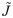
Long-range interactions can stabilize Counter patterns against variations in system size and morphogen signal.(A) Morphogen signal for three different system sizes, N = 50, 60, 70. Posterior boundary of the system is depicted as a dashed line. We consider how a two-gene Counter network, optimized for N = 60, changes upon variations in system size. (B) Resulting patterns for a Counter network for three system sizes depicted in (A). The pattern does not scale with the system size; instead, boundaries form at the same absolute location. (C) Resulting patterns for the same network as in (B) with additional negative long range interactions. Pattern shifts with system size are largely suppressed. (D) Spatial interaction strength as a function of distance. Nearest neighbors are interacting positively, while sites further away are coupled negatively with exponentially decaying strength of maximal amplitude J˜. (E) We perturb the morphogen signal with a uniform perturbation ϵ, m˜(x) =m(x) + ϵ. Example patterns generated by the optimal Counter two-gene network, at different strengths of long range interactions, J˜, and different morphogen signal perturbation magnitudes, ϵ. At ϵ = 0, irrespective of J˜, the system generates the optimal pattern. When |ϵ| increases, the patterns shift (providing less PI) with weak J˜, but when J˜ is strong, the pattern is robust to such perturbations. (F) To quantify the robustness to ϵ perturbations, we compute the overlap, S, of the resulting pattern with the optimal Counter pattern. The overlap is shown as a function of ϵ and J˜; for strong negative J˜, the overlap is high irrespective of the perturbation strength, ϵ. (G) Susceptibility to small perturbations ϵ as a function of J˜ shows transition into a robust regime, χm → 0, as J˜ increases in magnitude.